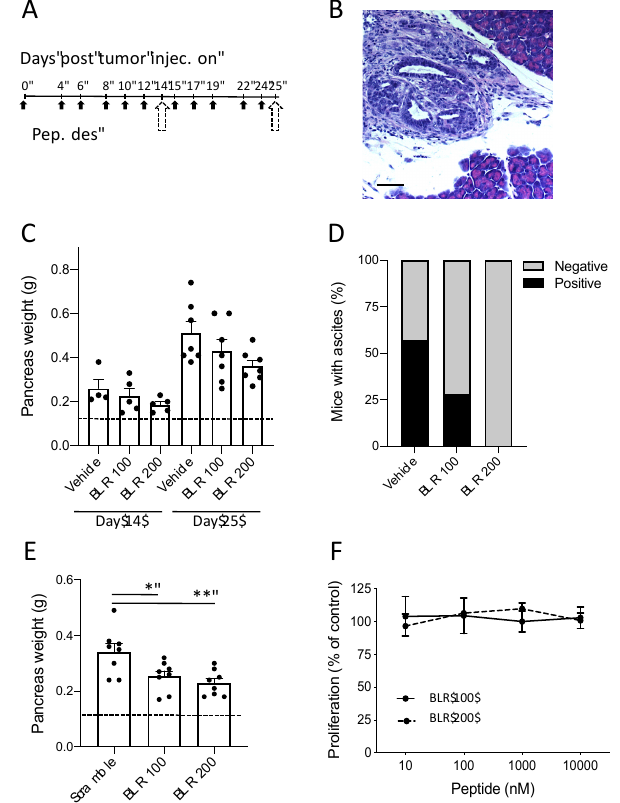
Figure 2. Antineoplastic activity of BLR100 or BLR200 on PDAC. ( A ) Schedule of treatment. The peptides were administered three times per week at 4.5 µg/kg, at the indicated day (black arrows). Dotted arrows indicate mice sacrifice and analysis on days 14 and 25. ( B ) Tumor in the pancreas of mice 4 days after tumor transplantation (H&E staining, scale bar 100µm). ( C ) Tumor burden (evaluated as pancreas weight) in mice bearing FC1199 orthotopic tumors treated with vehicle, BLR100, or BLR 200 on day 14 (n = 5) or 25 (n = 7). Dotted line indicates the weight of pancreas in healthy mice. ( D ) Effect of treatments on ascites formation. Data are the percentage of mice presenting (black) or not (gray) ascites on day 25 (n = 7). ( E ) Tumor burden in mice treated with a scramble peptide, BLR100, or BLR200 (10 µg/kg) and sacrificed 25 days after tumor transplantation (n = 8). Dotted line indicates the weight of the pancreas in healthy mice. In C and E, data are mean ± SEM. One way ANOVA and Tukey’s, ** p < 0.005; * p < 0.05. ( F ) E ff ect of BLR100 or BLR200 on FC1199 cell proliferation in vitro. Data are the percentage of control proliferation, mean ± SEM of values from 2 independent